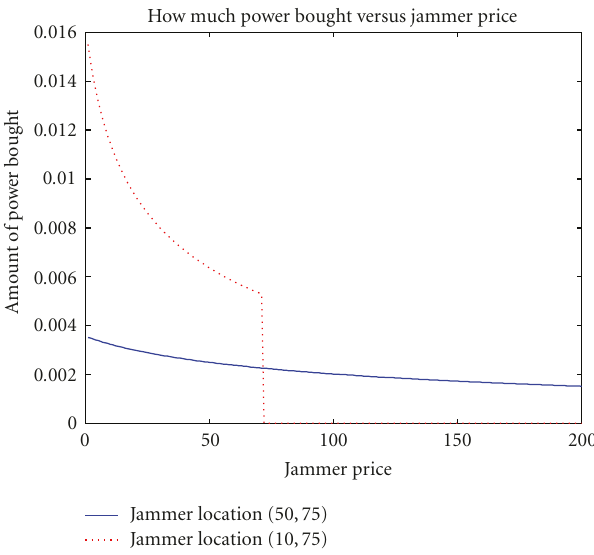
Figure 3: How much power the source buys as a function of the